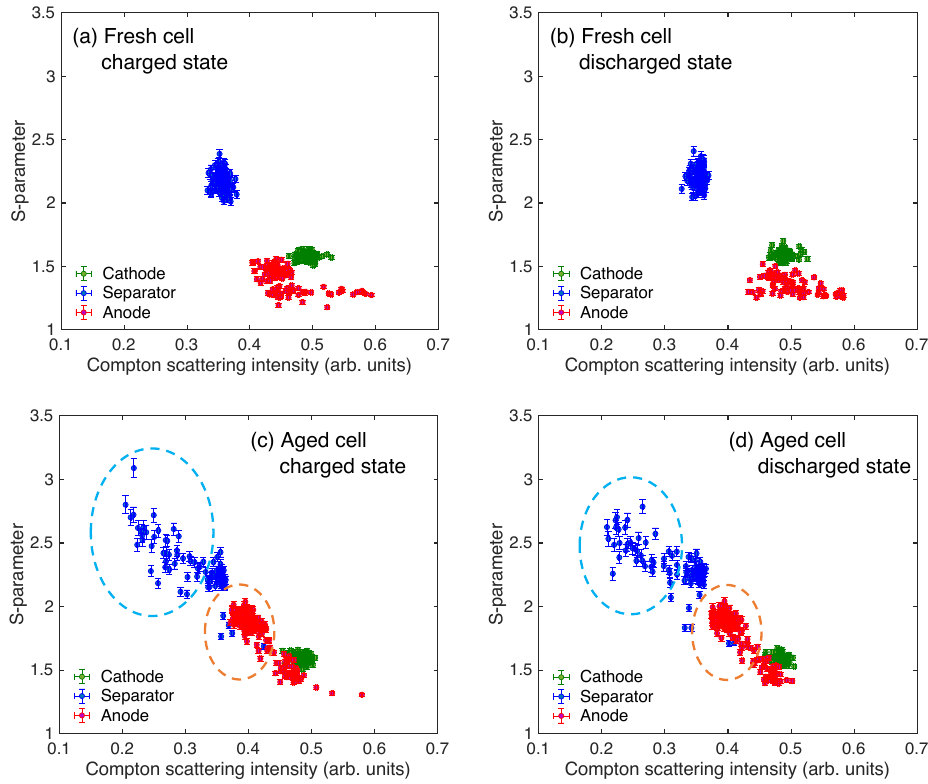
Figure 5. The correlation between the Compton scattering intensity and S-parameter. The data obtained from the cathode, anode, and separator are shown in green, red, and blue circles, respectively. ( a ) The charged state of the fresh cell. ( b ) The discharged state of the fresh cell. ( c ) The charged state of the aged cell. ( d ) The discharged state of the aged cell. The distribution regions characterizing the aged cell are highlighted in blue and orange dotted line circles in Figure